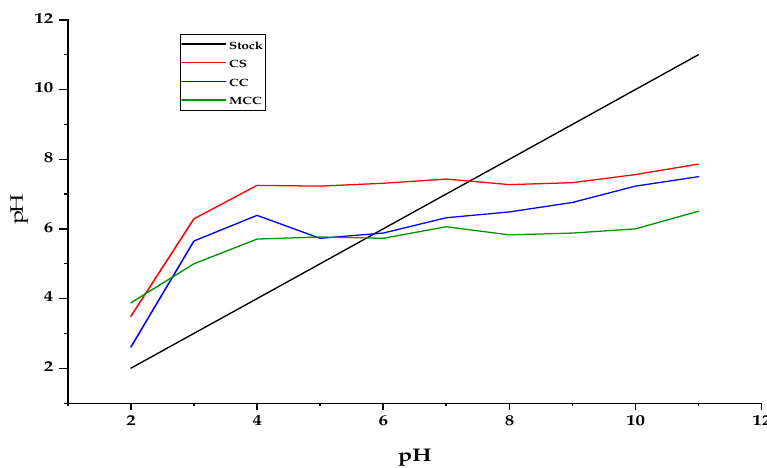
Figure 2. pH PZC of bioadsorbents from coconut coir.